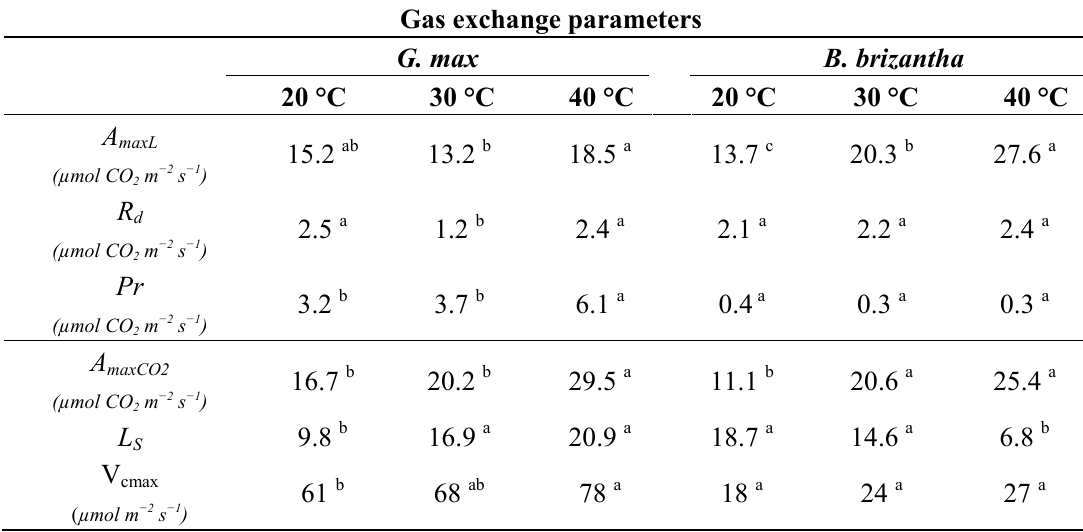
Table 1. Mean values of photosynthetic capacity ( A photorespiration ( Pr ), photosynthetic potential ( A photosynthesis ( Ls ), and maximum ratio of Rubisco carboxylation ( V B. brizantha under different temperature conditions (°C).